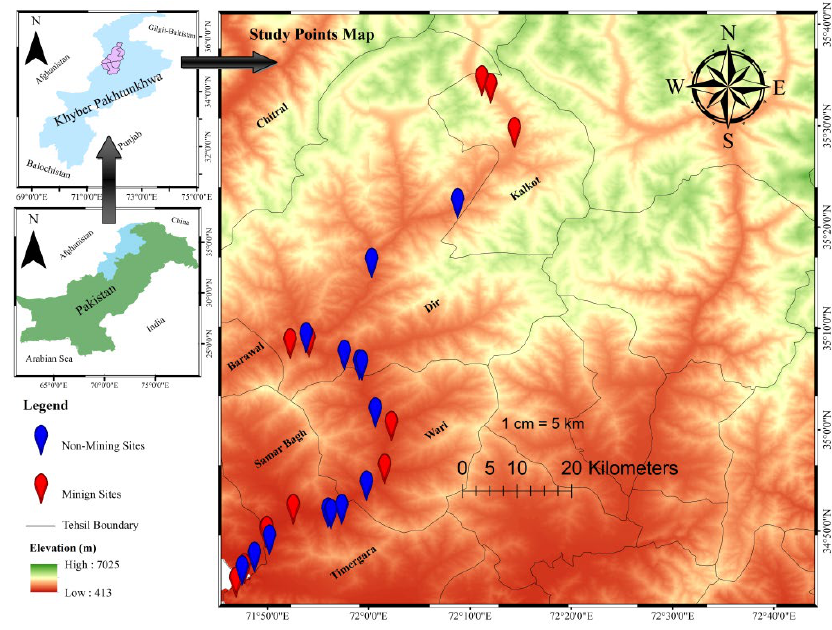
Figure 1. Study area map showing sampling points across the River Panjkora in Khyber Pakhtunkhwa,